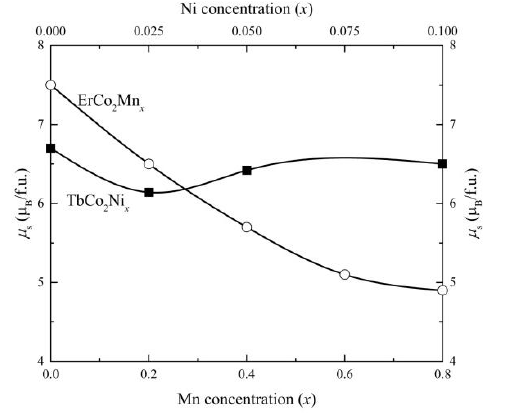
Fig. 4. Concentration dependences of the spontaneous magnetic moment at 4 K for ErCo 2 Mn x ( ○ ) and TbCo 2 Ni x ( ■ ) compounds.